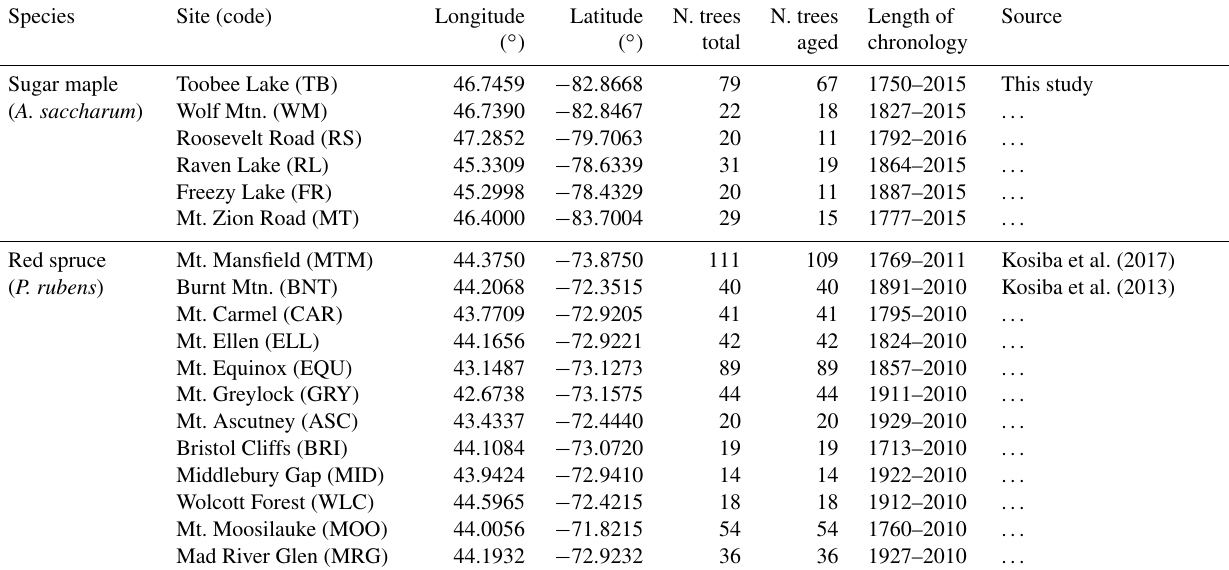
Table 1. Location, sample size, chronology length, and source of tree ring data sets used in this study.